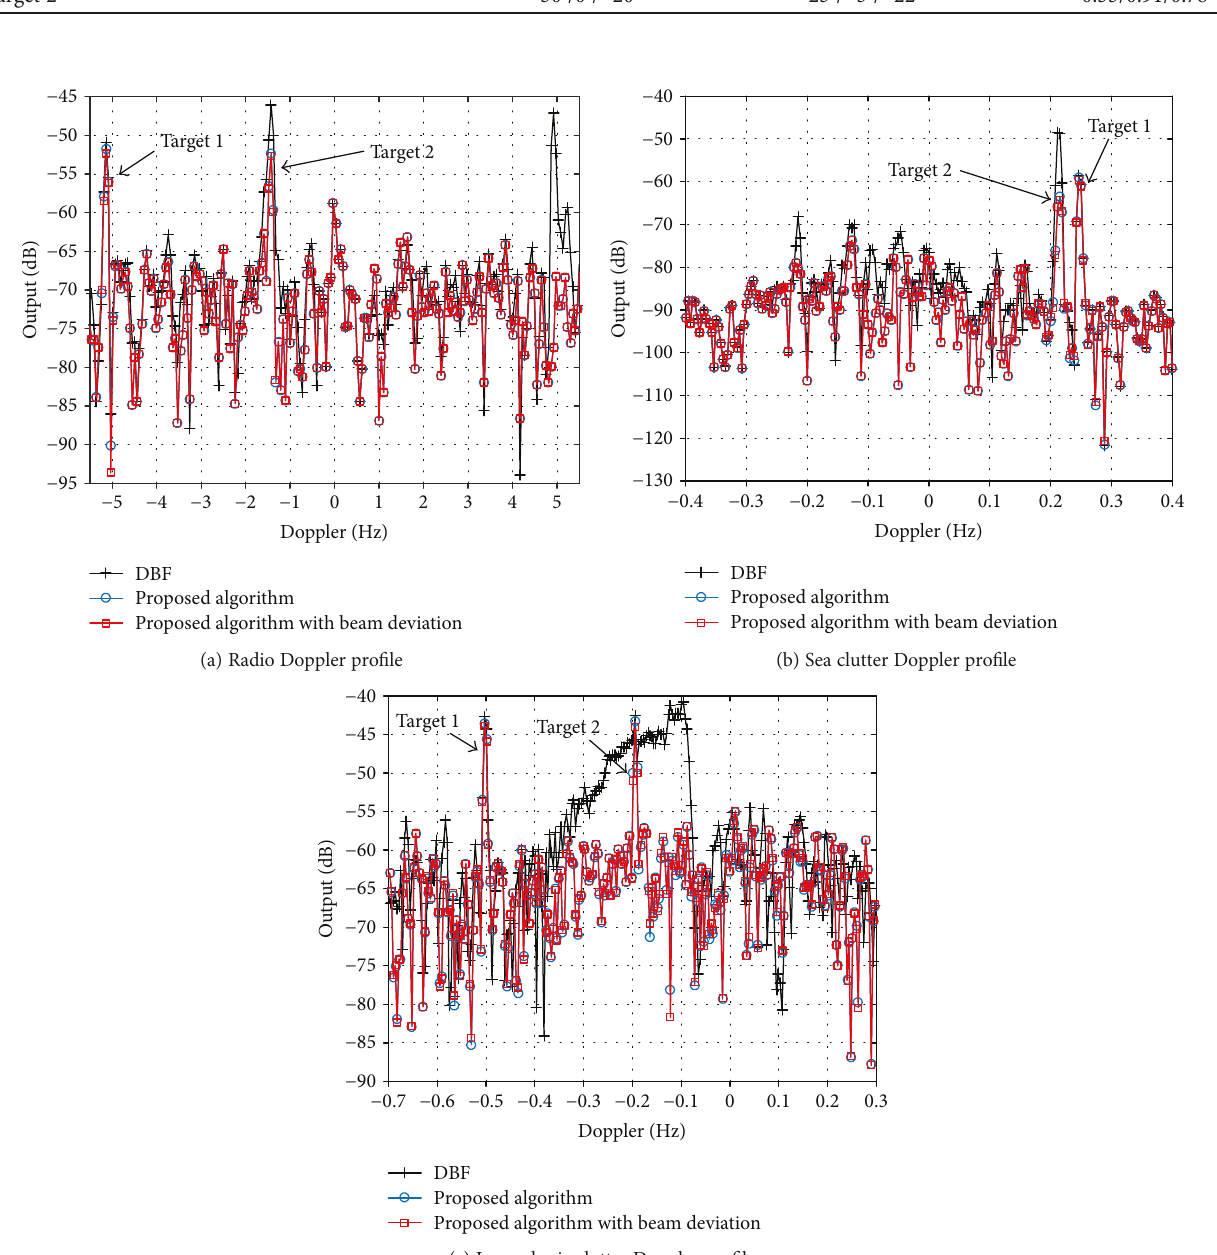
Figure 13: Robustness analysis of beam deviation with the simulated real